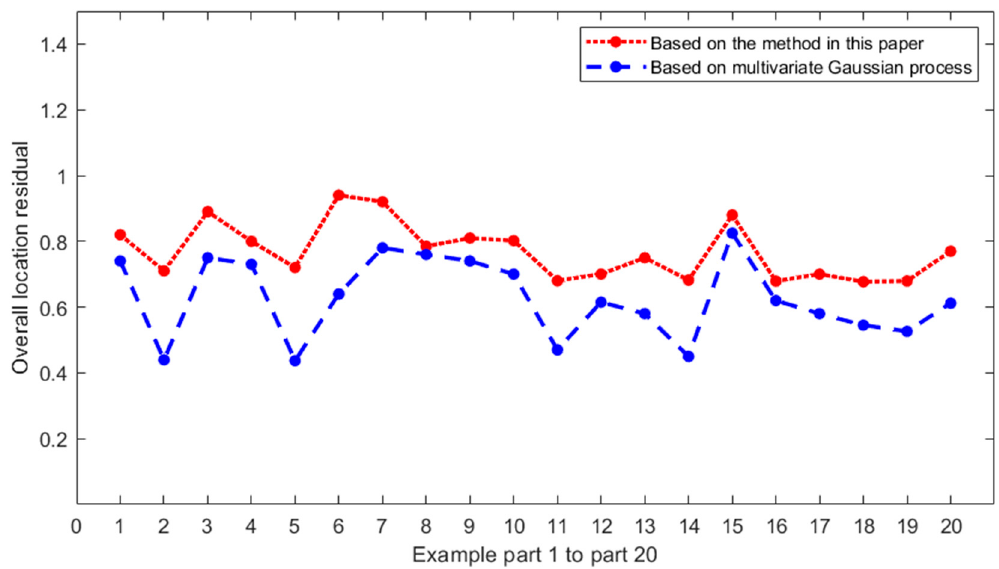
Figure 6. Comparison of overall location residuals of the predictive machined surface using the multivariate Gaussian process and using the method proposed in this paper.